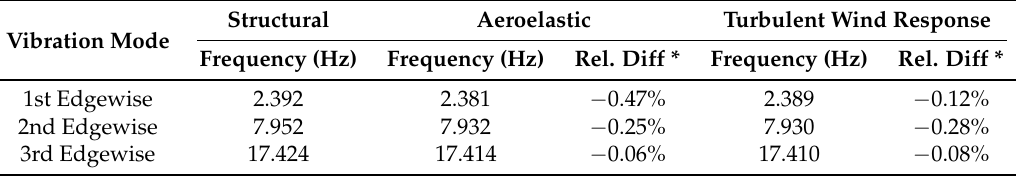
Figure 16. Fourier transform of the blade’s edgewise vibration displacement at the tip. Table 8. Edgewise natural frequencies of the Tjaereborg 2-MW wind turbine